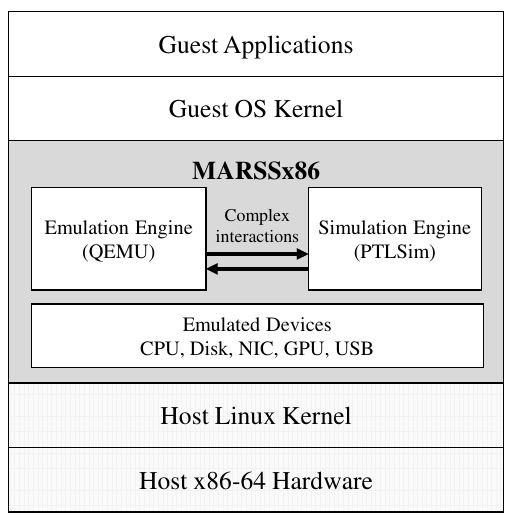
Figure 3. MARSSx86 simulator